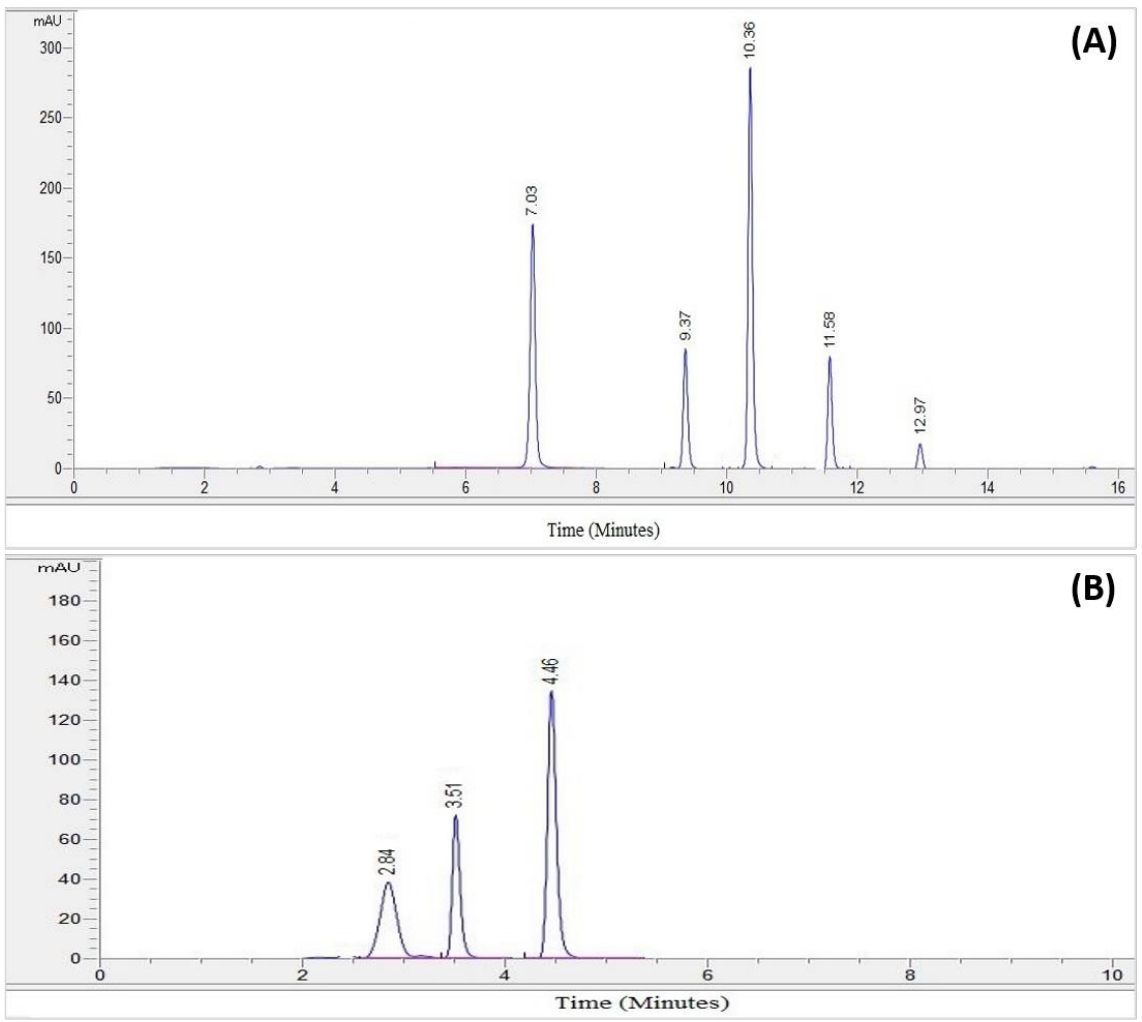
Figure 2. ( A ) The chromatogram of the standard phenolic compounds. ( B ) The chromatogram of the standard flavonoid compounds.